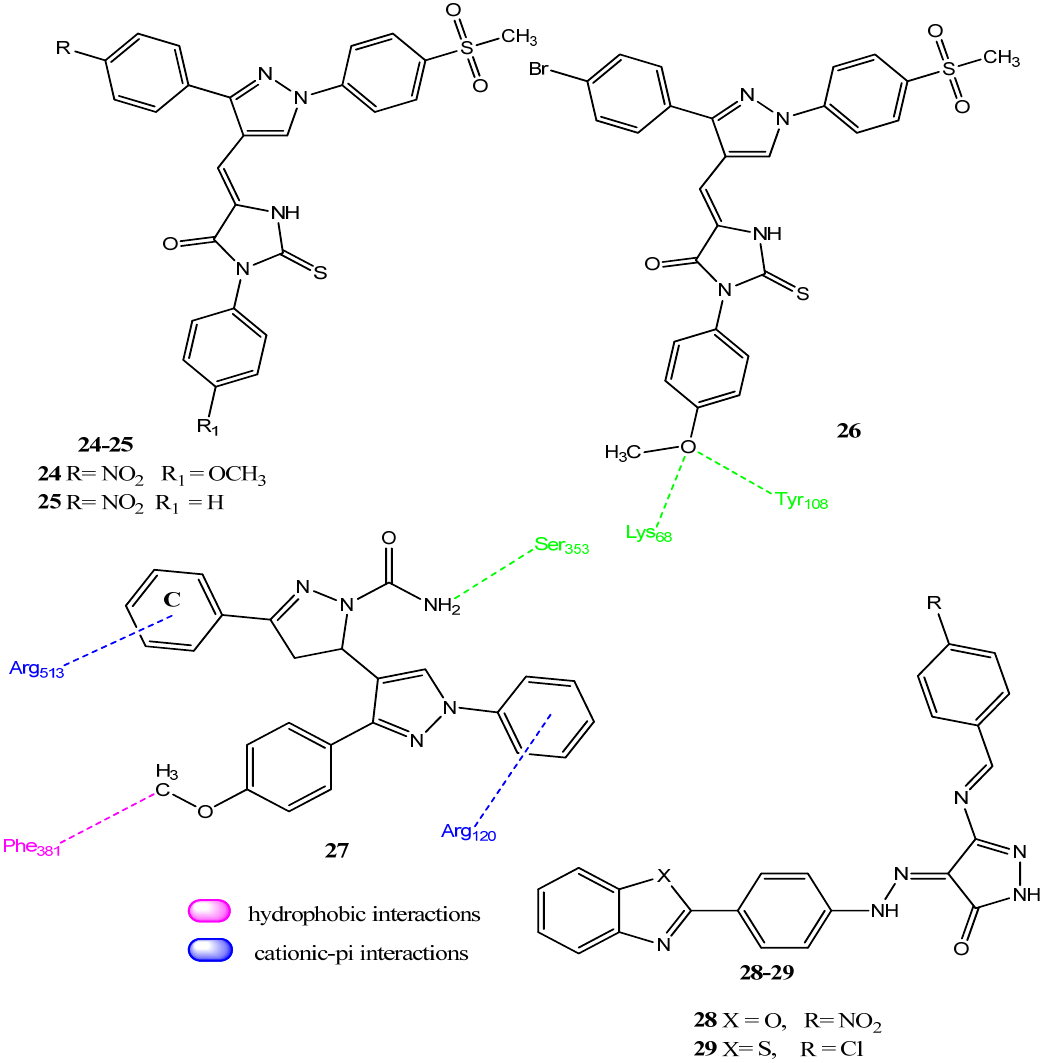
Figure 6. Pyrazole–based hybrid molecules and their interactions with COX-2 . El-Zahar and co-workers synthesized new hybrid compounds by the attachment of pyrazole/thiazole heterocyclic rings to the triazole scaffold. The thiazole, pyrazole, and thiosemicarbazone derivatives showed significant inhibition of COX-2. Compound 30 (IC 50 = 0.04 µM; SI= 310 Figure 7) emerged as the most potent inhibitor and showed